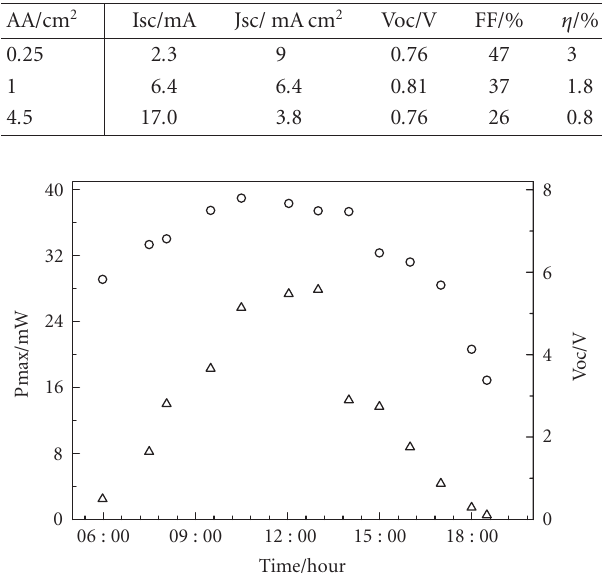
Table 1: Photocurrent (Isc), density of current (Jsc), voltage (Voc), fill factor (FF), and e ffi ciency ( η ) presented by dye-sensitized so- lar cells assembled with polymer electrolyte (P(EO-EPI)87 : 13 +